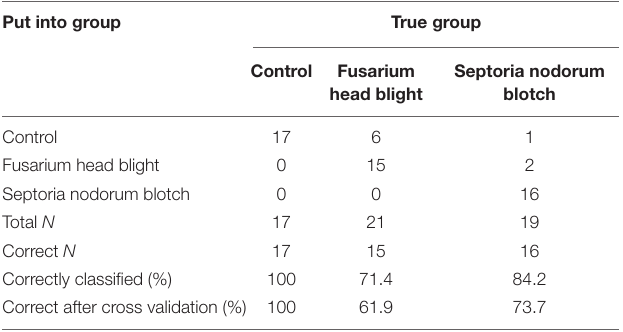
TABLE 6 | Summary of classification for fungal isolates grouped into diseases based on linear discriminant analysis with disease group as a response and 1-octen-3-ol; 3,5,5-trimethyl-2-hexene; germacrene D; α -patcholene; 2-(1-cyclopent-1-enyl-methylethyl)cyclopentanone; and mellein as the predictors.